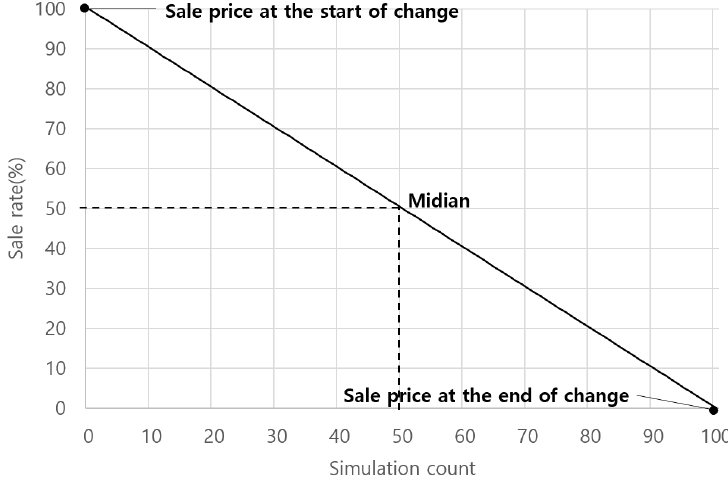
Figure 13. Pre-sale rate according to the time of simulation.